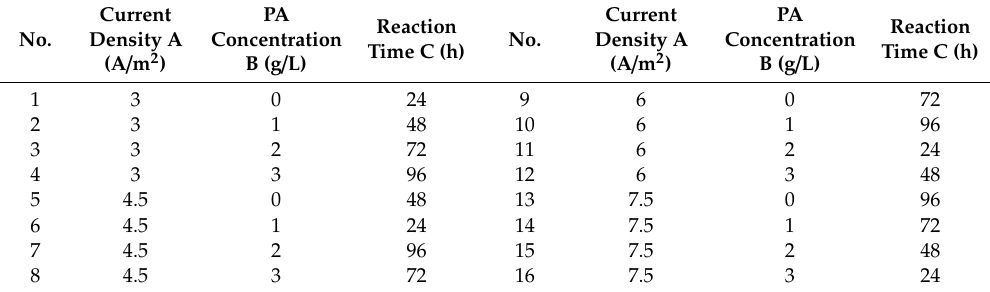
Table 2. The L 16 (3 4 ) orthogonal array for the electrochemical catalytic treatment